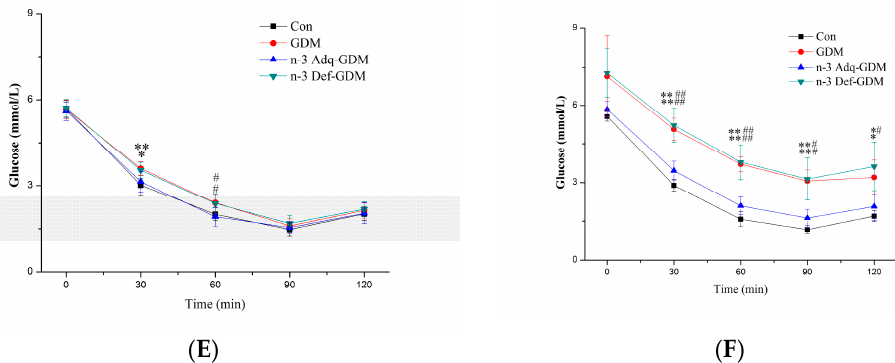
Figure 2. Glucose tolerance test ( GTT) and insulin tolerance test (ITT) in growing gestational diabetes mellitus (GDM) offspring and the effect of n-3 polyunsaturated fatty acids (n-3 PUFA). ( A ) GTT at weaning; ( B ) GTT at 3 months; ( C ) GTT at 11 months; ( D ) ITT at weaning; ( E ) ITT at 3 months; ( F ) ITT at 11 months. Values are the mean ± SD. n = 8 rats/group. * p < 0.05, ** p < 0.01, vs. Control offspring (Con); # p < 0.05, ## p < 0.01, vs. n-3 Adequate-GDM offspring (n-3 Adq-GDM); $ p < 0.05, n-3 Deficient-GDM offspring (n-3 Def-GDM) vs GDM offspring (GDM).